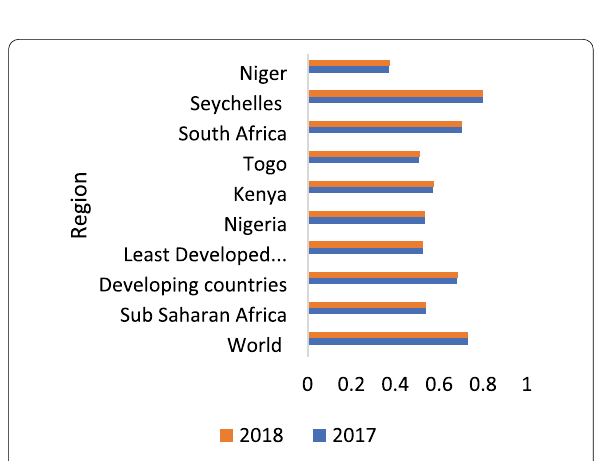
Fig. 2 Human Development Index